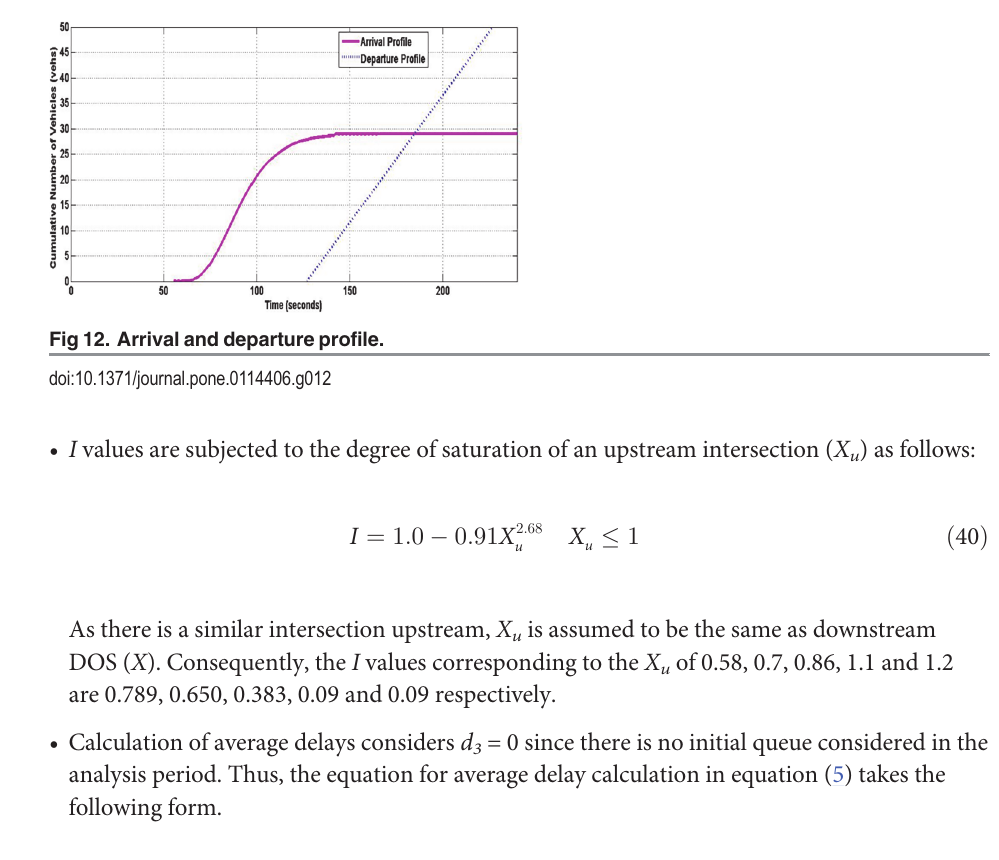
values of PF, I and X .